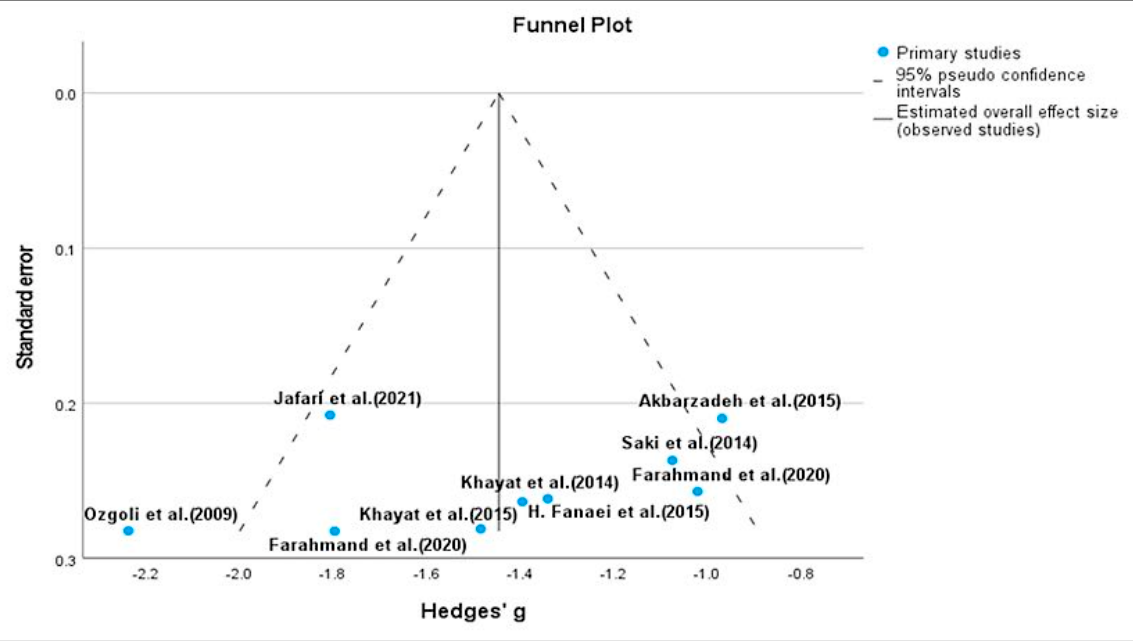
Figure 5. Funnel plot for PSST [5,7,45,47,49–51,54,55]. Meta-Analysis for DSR Scores